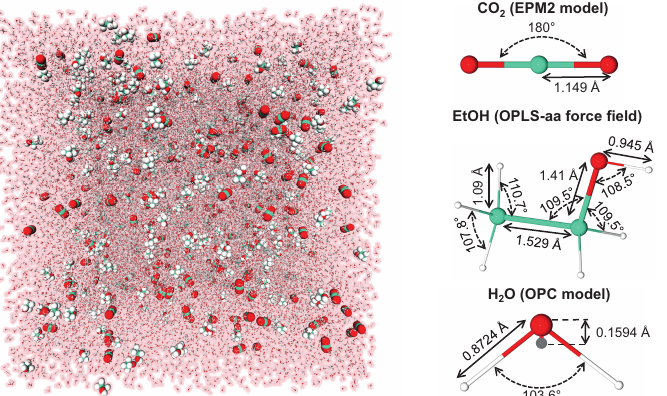
Figure 5. Example of simulation box containing 4 × 10 4 H 2 O, 200 CO 2 and 385 EtOH (3% vol.). Bond distances and angles of the three molecules used in our model are indicated on the right panel. Pictures were generated with the VMD (Visual Molecular Dynamics) and Protein Imager softwares